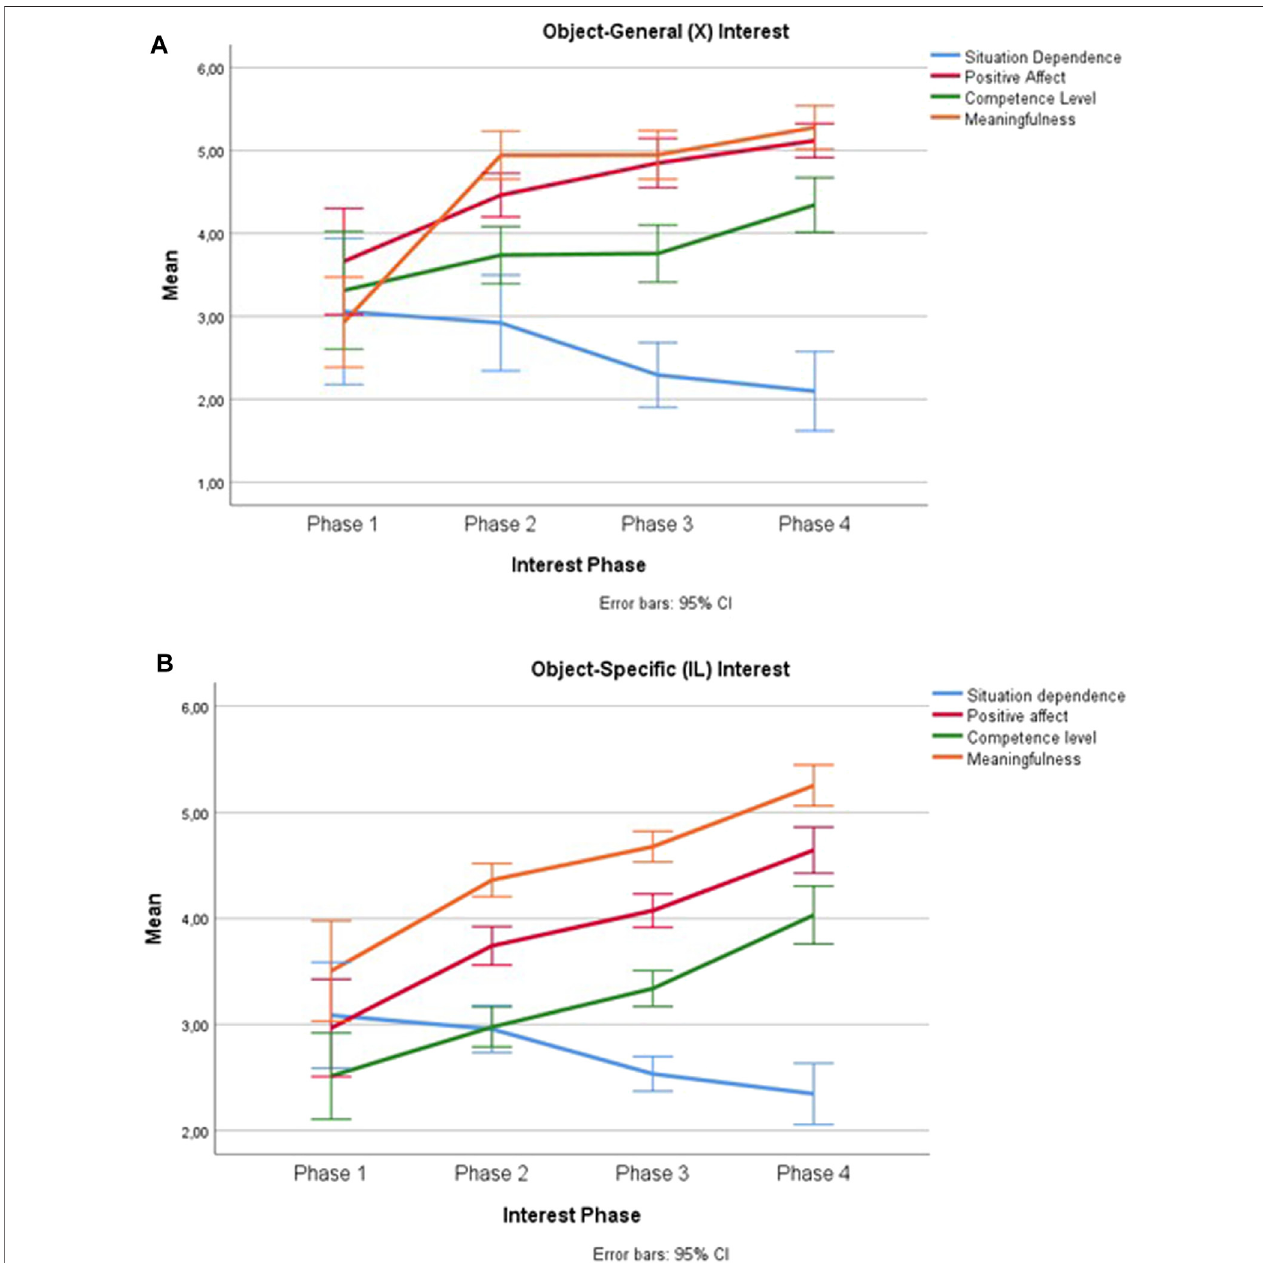
FIGURE4| Mean TRIQsubscale scoresforobject-general andobject-speci fi cinterestsbyphase(for comparison withoriginalhypotheses). (A) Object-general(X) relationships between key interest variables. (B) Object-speci fi c (IL) relationships between key interest variables.